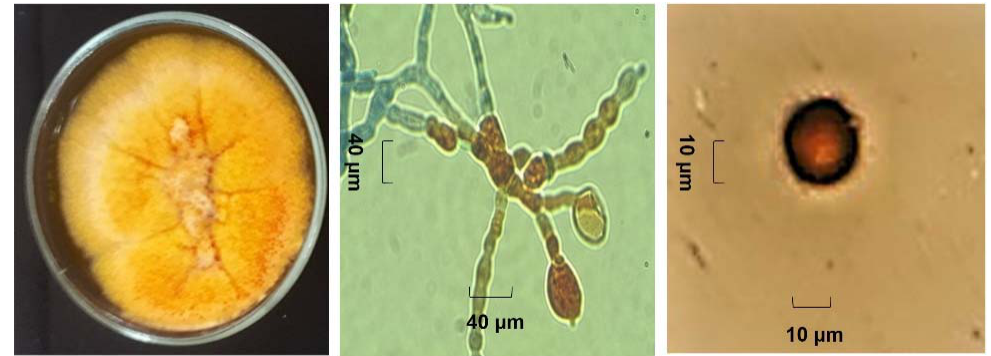
Figure 6. Morphological examination of the isolate Bl1. Colony on PDA ( Left ), sporodochia ( center ), and conidium ( right ).